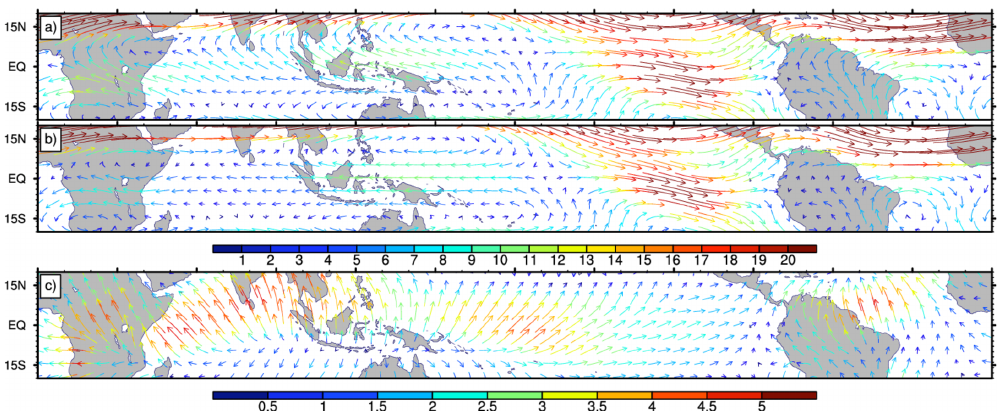
Figure 12. Climatological horizontal winds in January on ERA Interim model level 31 (about 229hPa) for (a) the total circulation, (b) balanced circulation and (c) unbalanced circulation. Wind intensity is shown by both colours and length of the wind vectors. Colour bar (in ms − 1 ) is the same for the total circulation and for the balanced circulation (every 1ms − 1 ), whereas the unbalanced winds are coloured with a spacing every 0.5ms − 1